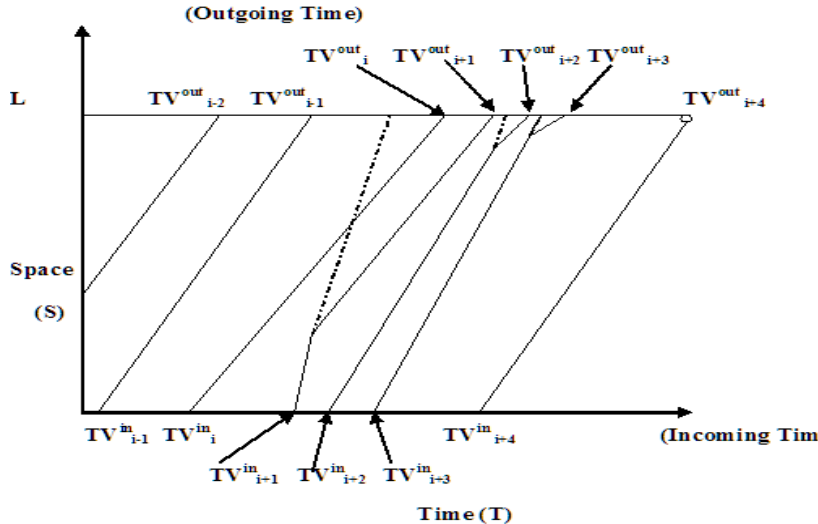
Figure 6. Traffic flow space vs. time (incoming and outgoing vehicles).